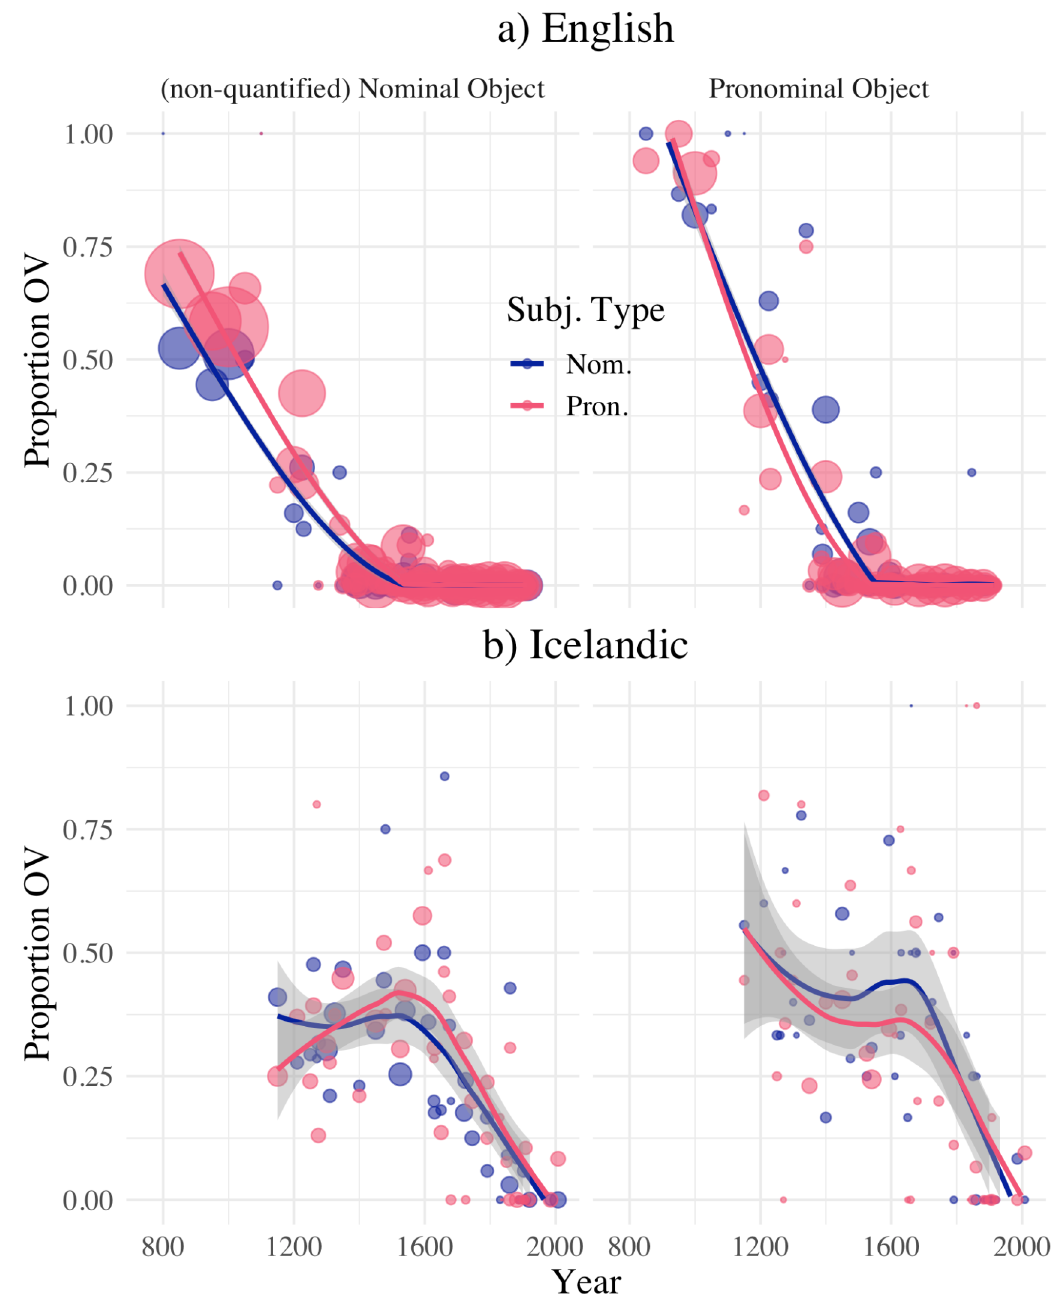
Figure 2. Proportion OV clauses by Subject type over time for all clauses in ( a ) English and ( b ) Icelandic. Note the larger data set for English (dot size represents number of data points for a year). In all cases, OV is favored when Object and Subject are of different types, and OV is dis favored when Objects and Subject are of the same type. Upper left: Given a nominal Object in English, nominal Subjects (blue line) disfavor OV, while pronominal Subjects (pink line) favor OV. Upper right: Given a pronominal Object in English, pronominal Subjects (pink line) disfavor OV, while nominal Subjects (blue line) favor OV. Lower left: Given a nominal Object in Icelandic, nominal Subjects (blue line) disfavor OV, while pronominal Subjects (pink line) favor OV. Lower right: Given a pronominal Object in Icelandic, pronominal Subjects (pink lane) disfavor OV, while nominal Subjects (blue line) favor